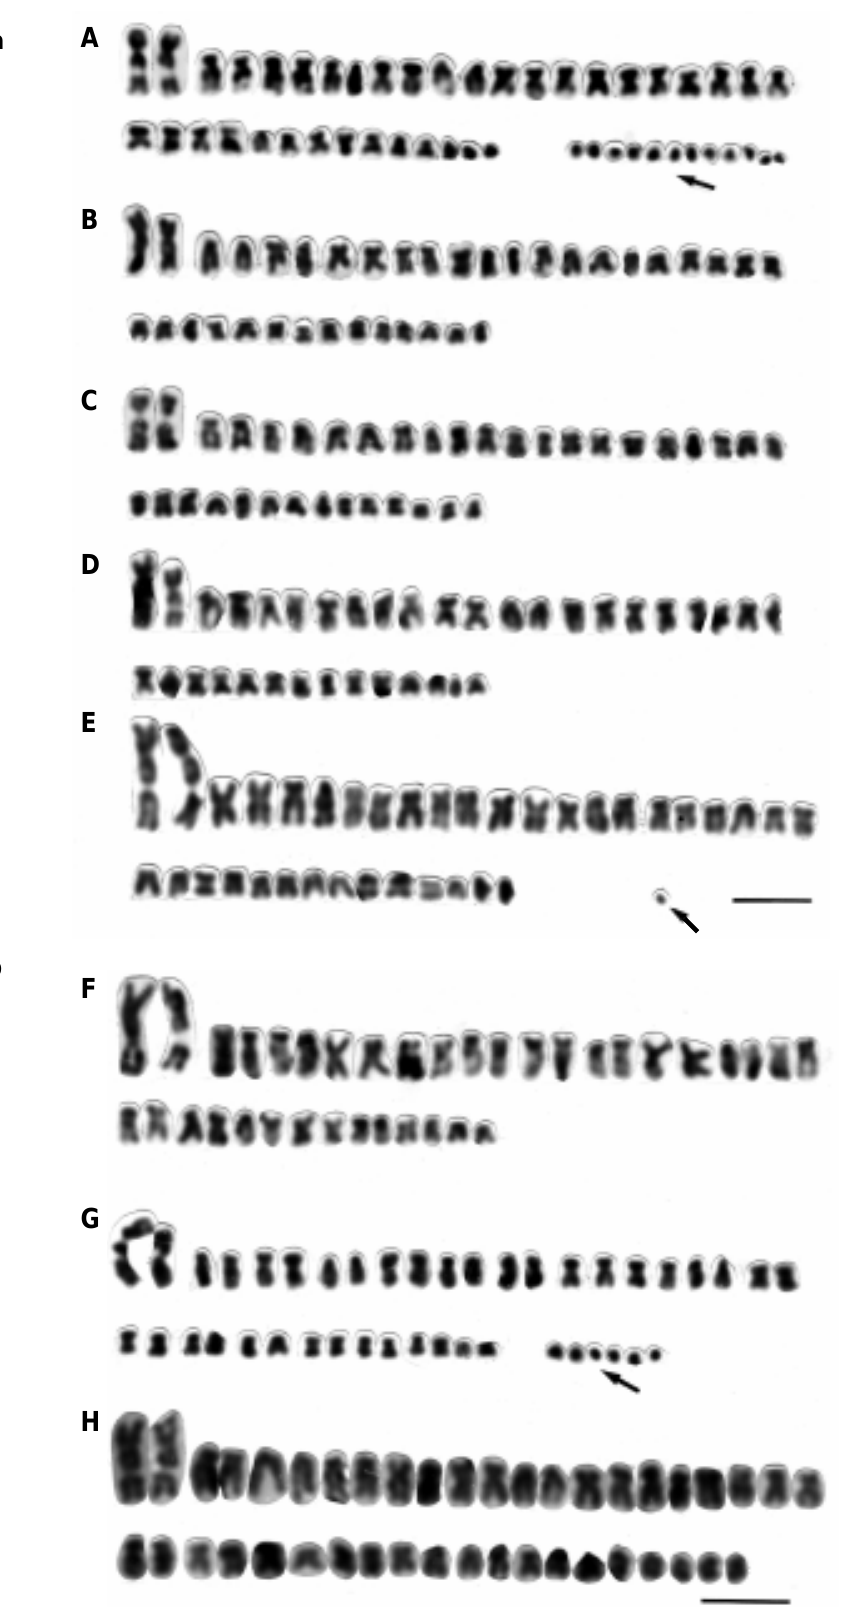
Figure 1 - a, Karyotypes of diploid cytotypes of Mikania micrantha . A. Piracicaba, B. Petrópolis, C. Praia Grande, D. Alfredo Guedes, E. Estrela do Norte. Bar = 4 m m. Arrows indicate B-chromosomes. b, Karyotypes of three diploid cytotypes of Mikania micrantha . F. Praia de Ipanema, G. Campinas (with 2n = 36 chromosomes), H. Joinville (with 2n = 42 chromosomes). Bar = 4 m m. Arrow indicates